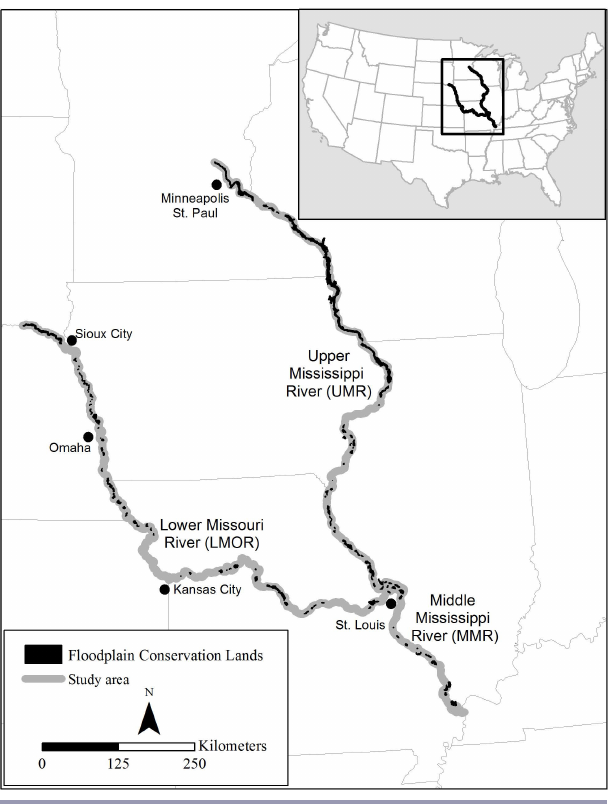
Fig. 1 . Floodplain conservation lands within the